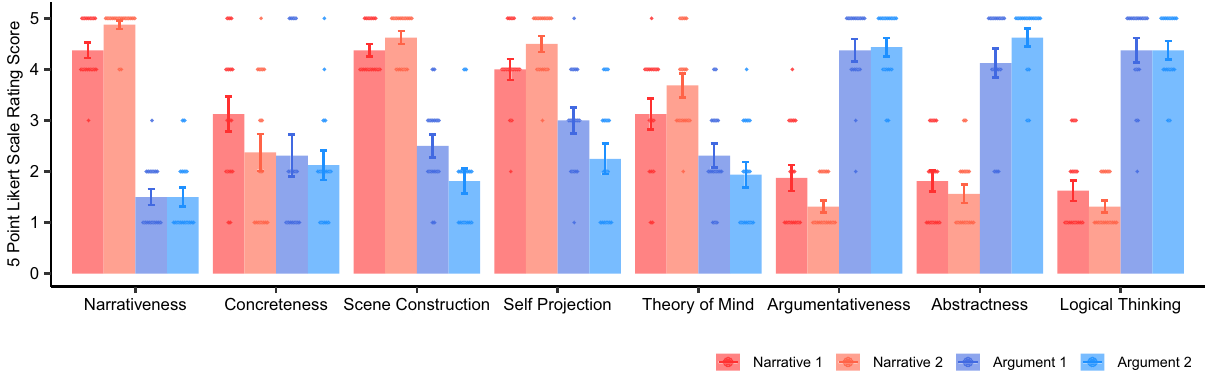
Fig. 2 Behavior rating of the four selected texts. The fi gure shows the four selected texts ’ rating scores on eight items from the 16 participants who participated in the fMRI experiment after the scanning. The dots denote the rating scores of individual participants, the bars denote the mean rating score across participants, and the error bars denote the standard error of the mean rating score. The narrative texts had a signi fi cantly higher rating than the argumentative texts on narrativeness, scene construction, self-projection, and theory of mind. The argumentative texts had a signi fi cantly higher rating than the narrative texts on argumentativeness, abstractness, and logical thinking. The results largely validated the rating pattern from an independent group of participants at the stimulus selection stage, as shown in Supplementary Fig. 1. In this group, the narrative texts also had a signi fi cantly higher rating than the argumentative texts on